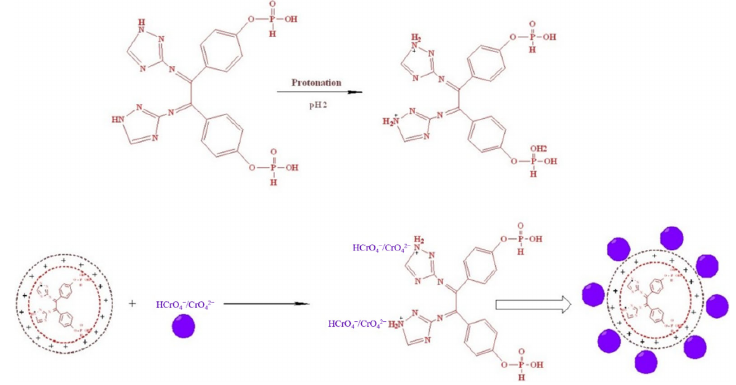
The behavior of Cr(VI) adsorption by TIHP at low pH may be related to the presence